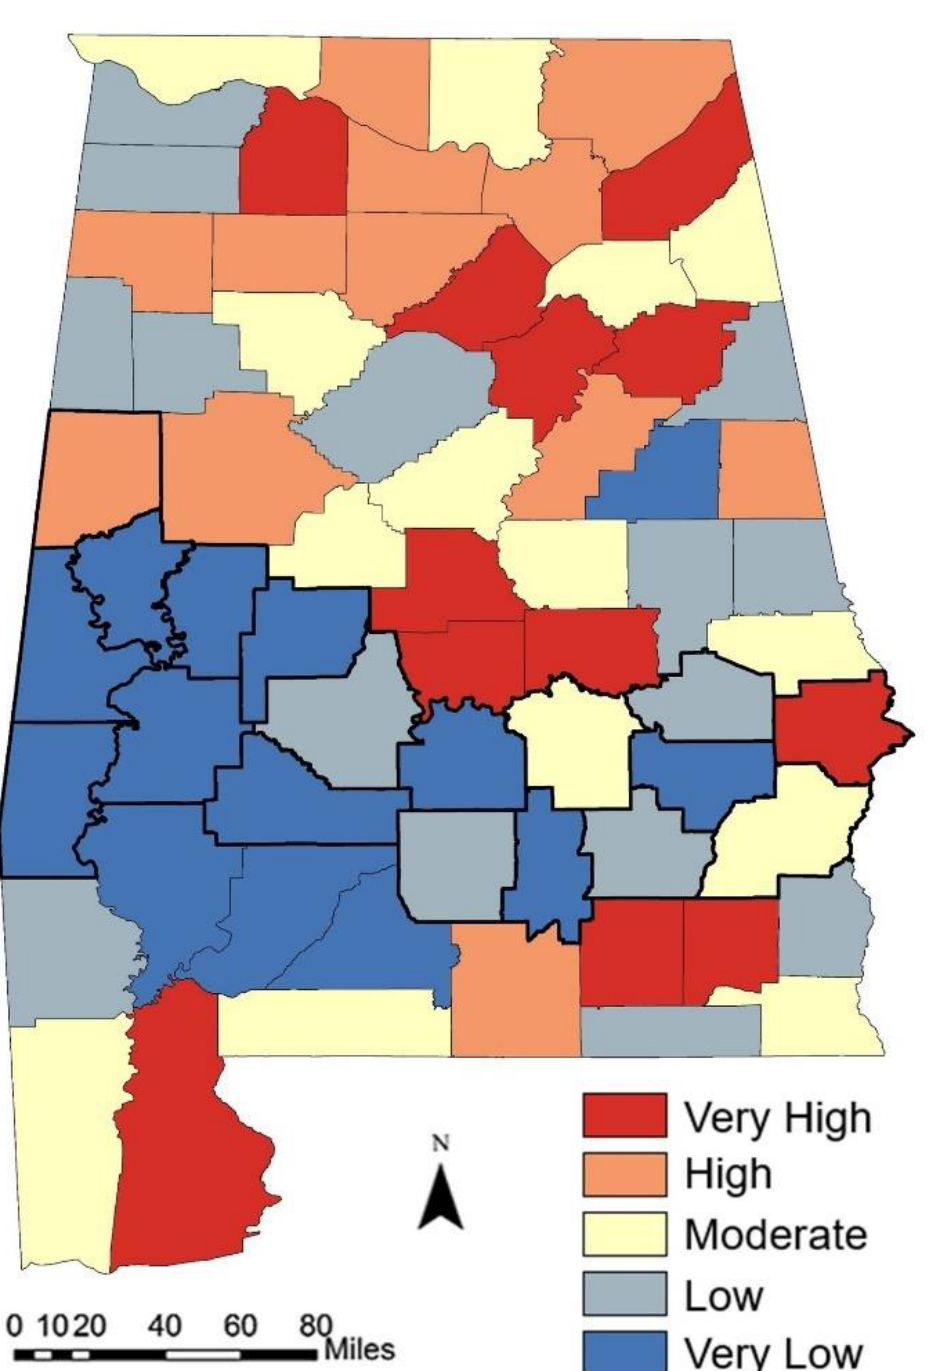
Figure 6. Spatial distribution of the adaptive capacity subindex. The scores are classified as quintiles. The thick black lines indicate the boundaries of Black Belt counties.